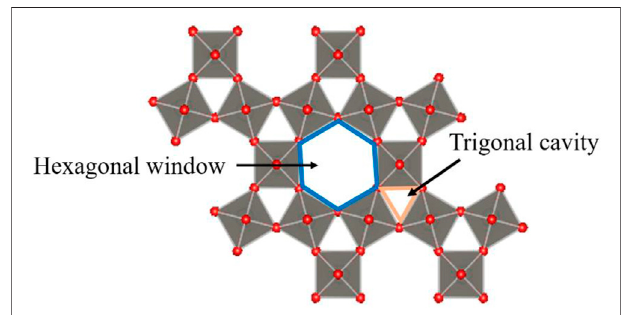
FIGURE 1 | The hexagonal window and trigonal cavity of the hexagonal WO 3 (001) surface (Balaji et al., 2009).